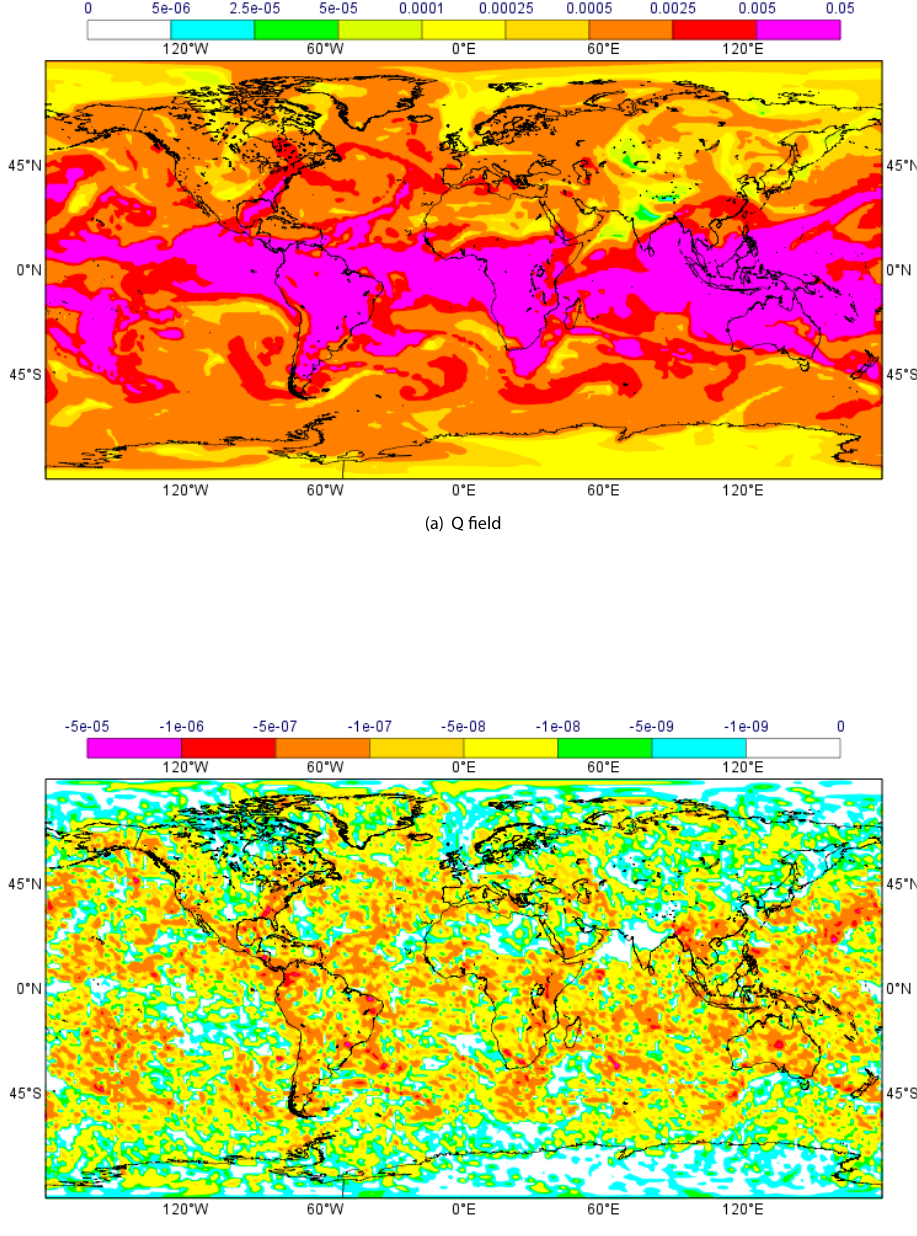
Figure 3. (a) Q and (b) BC fixer increment for Q (in kgkg − 1 ) at t+24h and 700hPa height from a T1279 L137 forecast.